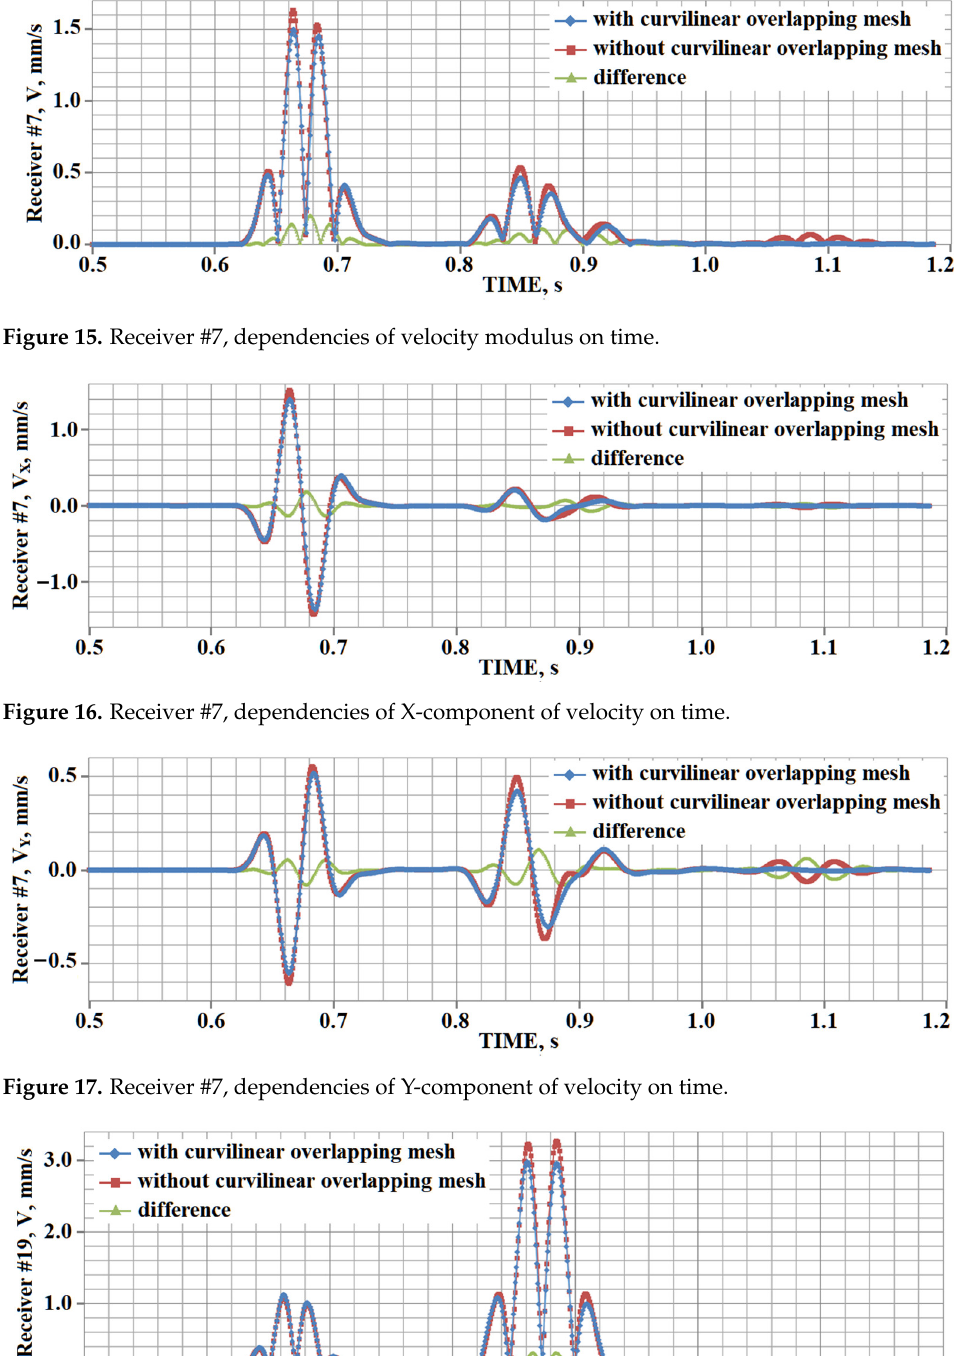
Figure 15. Receiver #7, dependencies of velocity modulus on time.